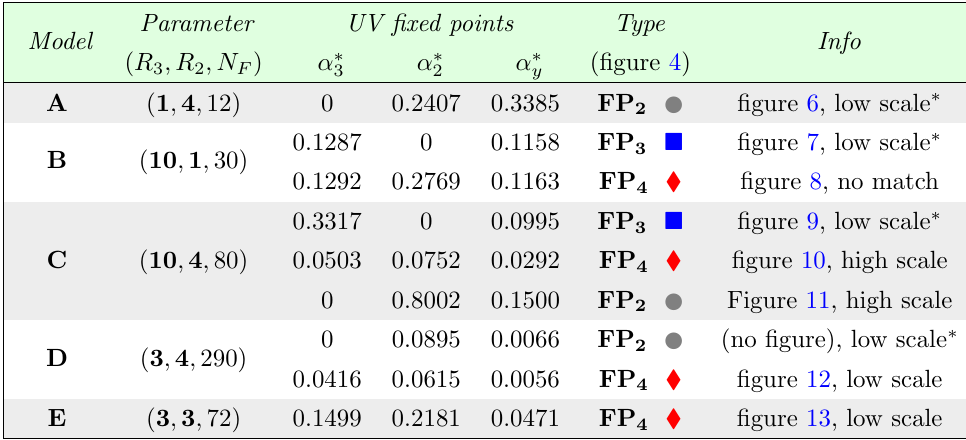
Table 7 . UV (cid:12)xed points and matching characteristics for various benchmark scenarios. An asterisk indicates that a matching is permitted at any scale including low (TeV) energy scales.